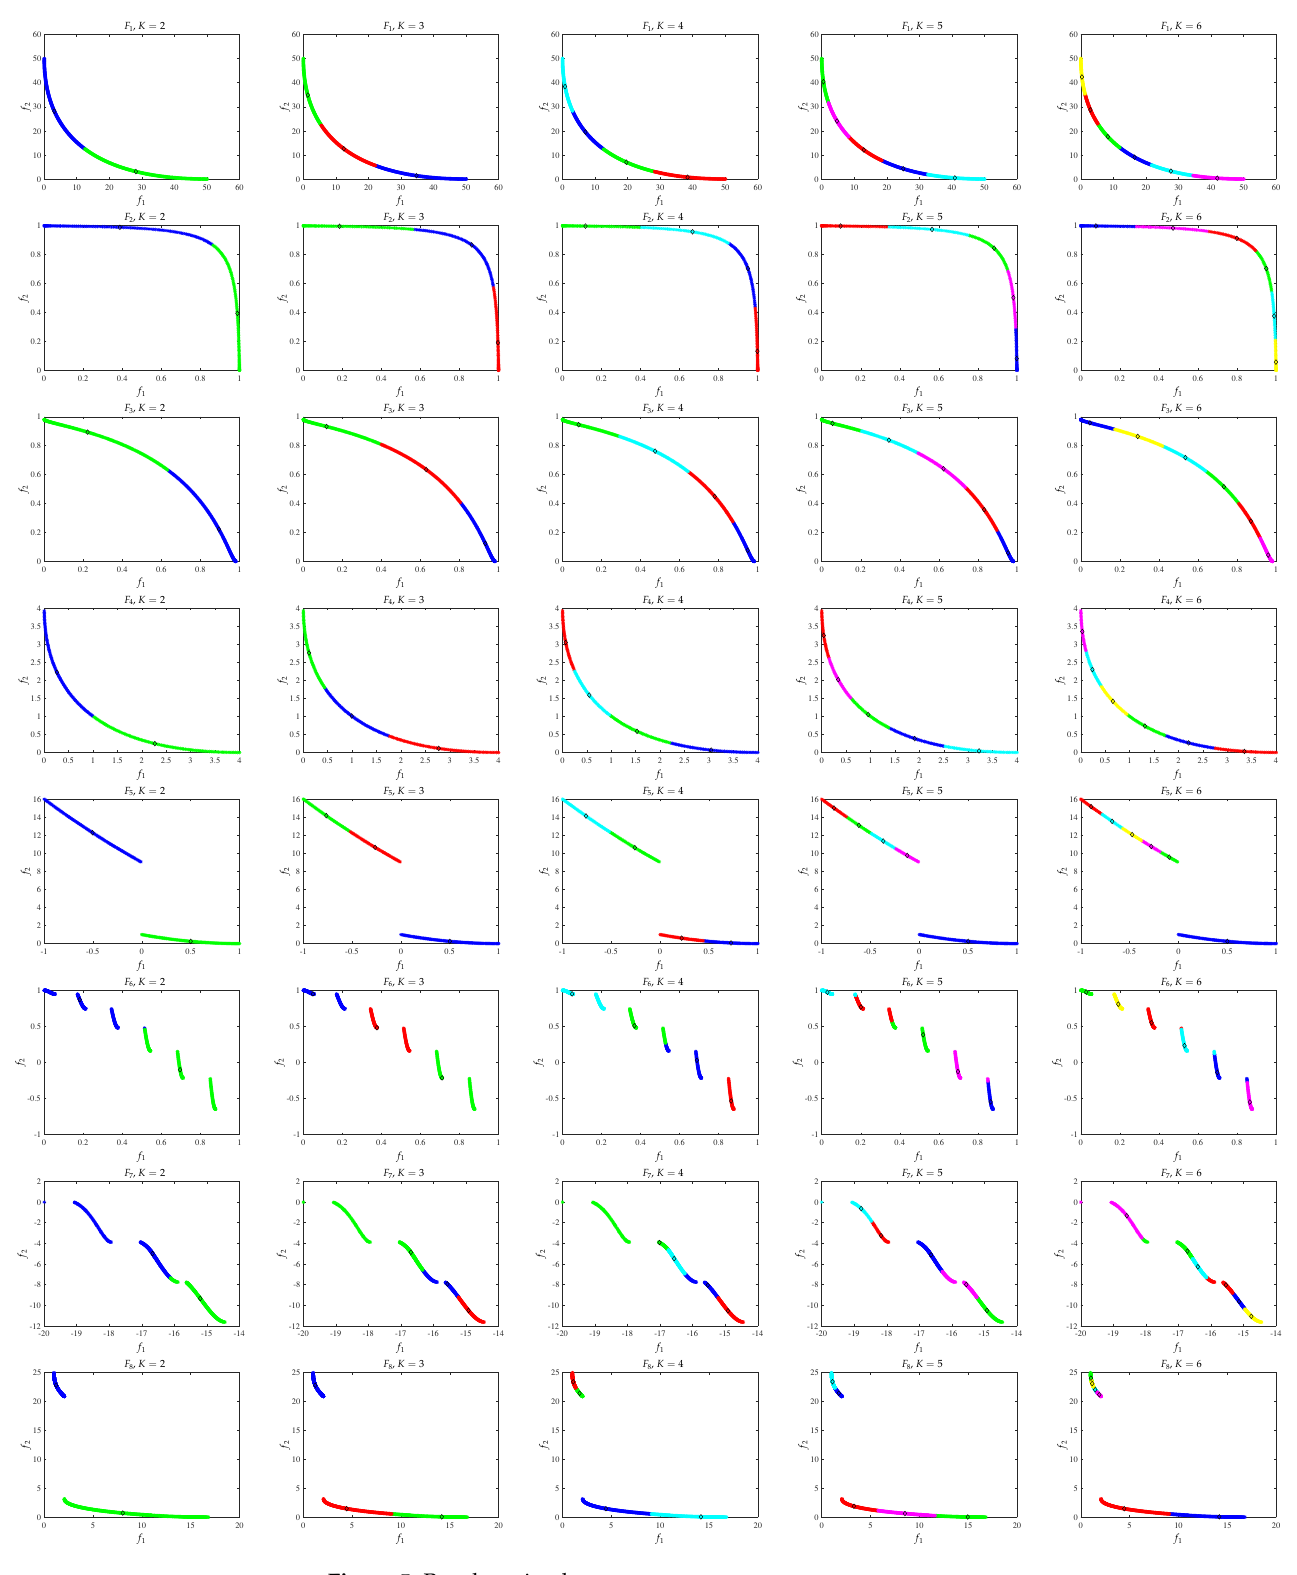
Figure 5. Results using